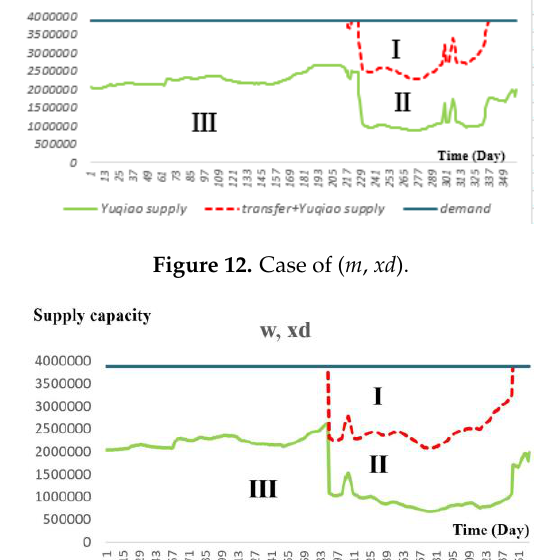
Figure 11. Case of (d, xd).